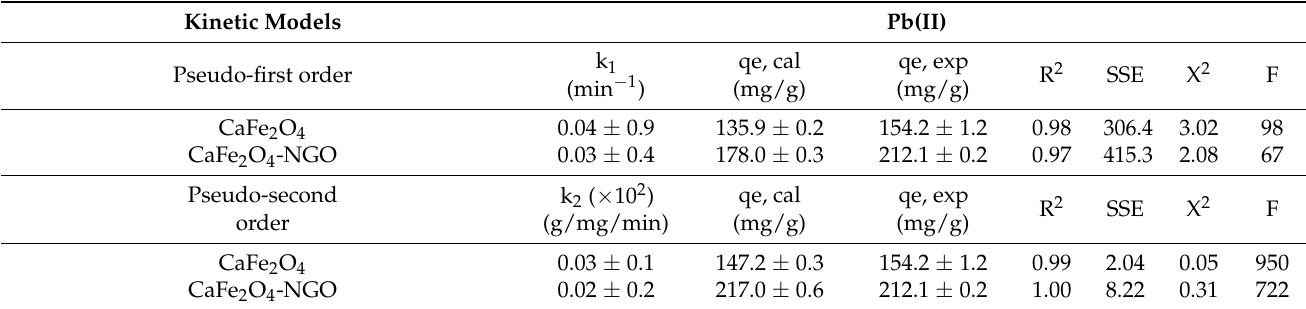
Table 3. Rate constant, equilibrium adsorption capacity, regression coefficient, and statistical data of pseudo-first and second-order kinetic models for the adsorption of Pb(II) ions.